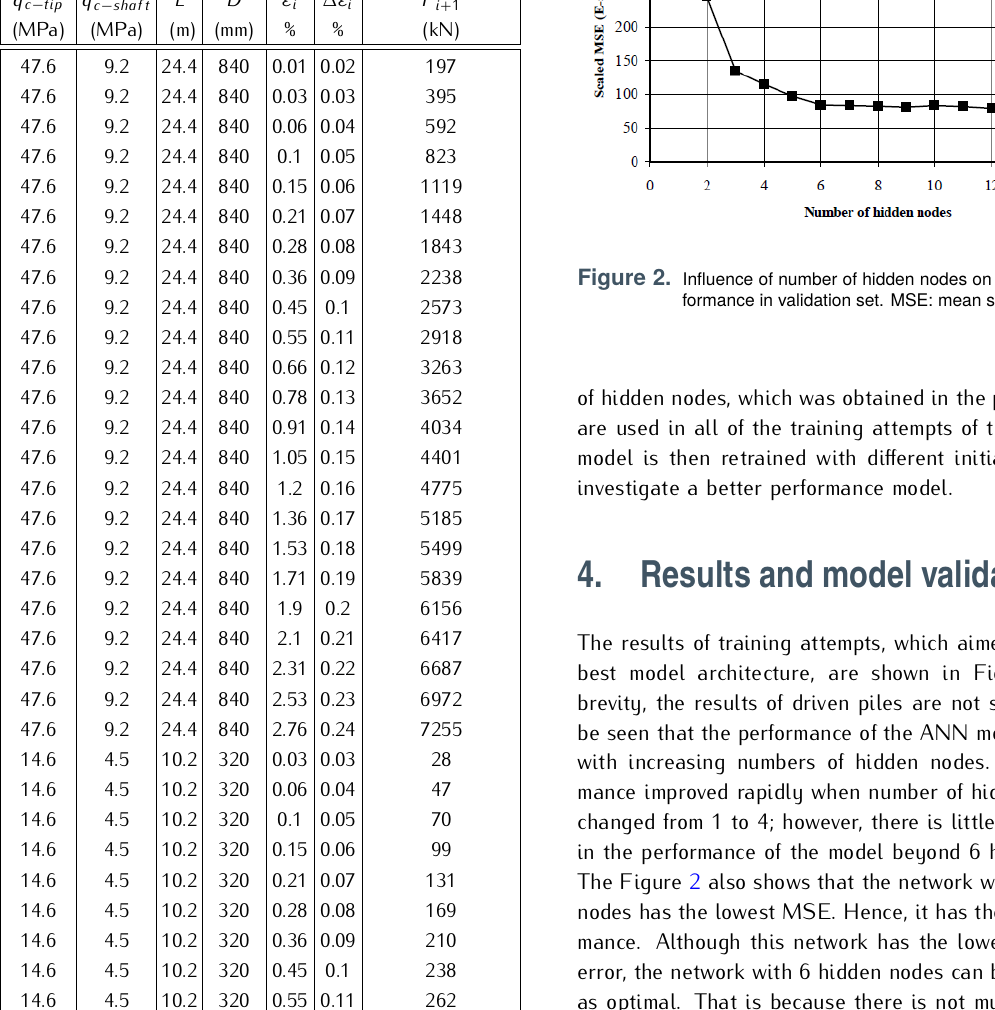
Figure 2. Influence of number of hidden nodes on ANN model per- formance in validation set. MSE: mean squared error.